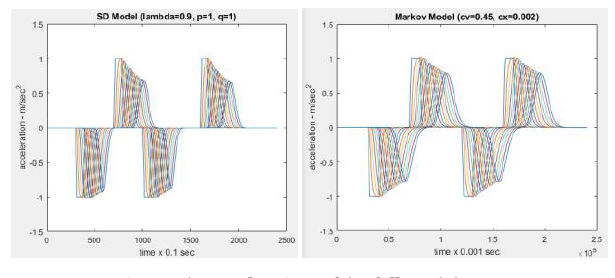
Fig. 3. The accelerations of the followed drones.